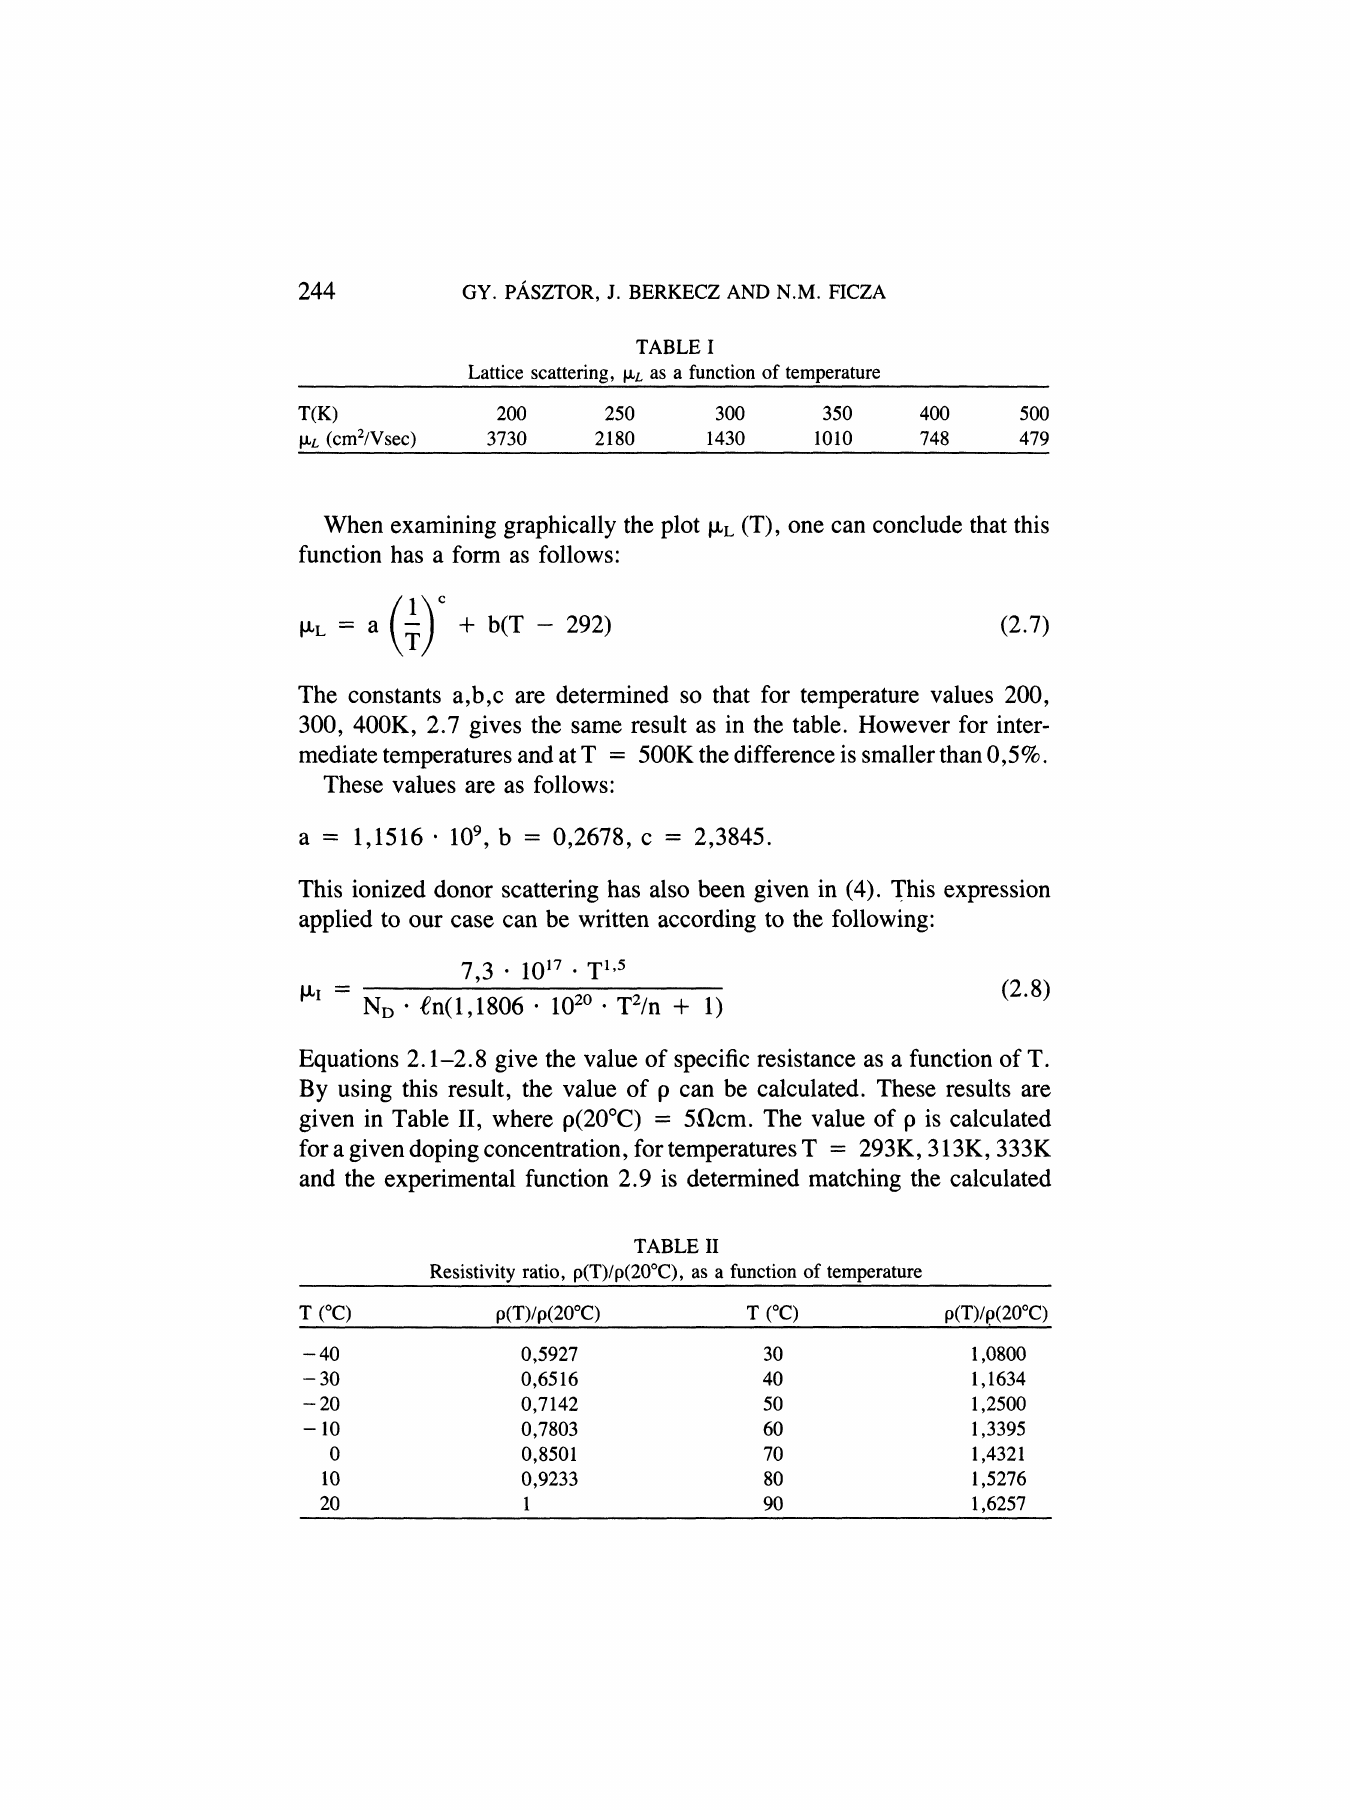
Resistivity ratio, p(T)/p(20C), as a function of